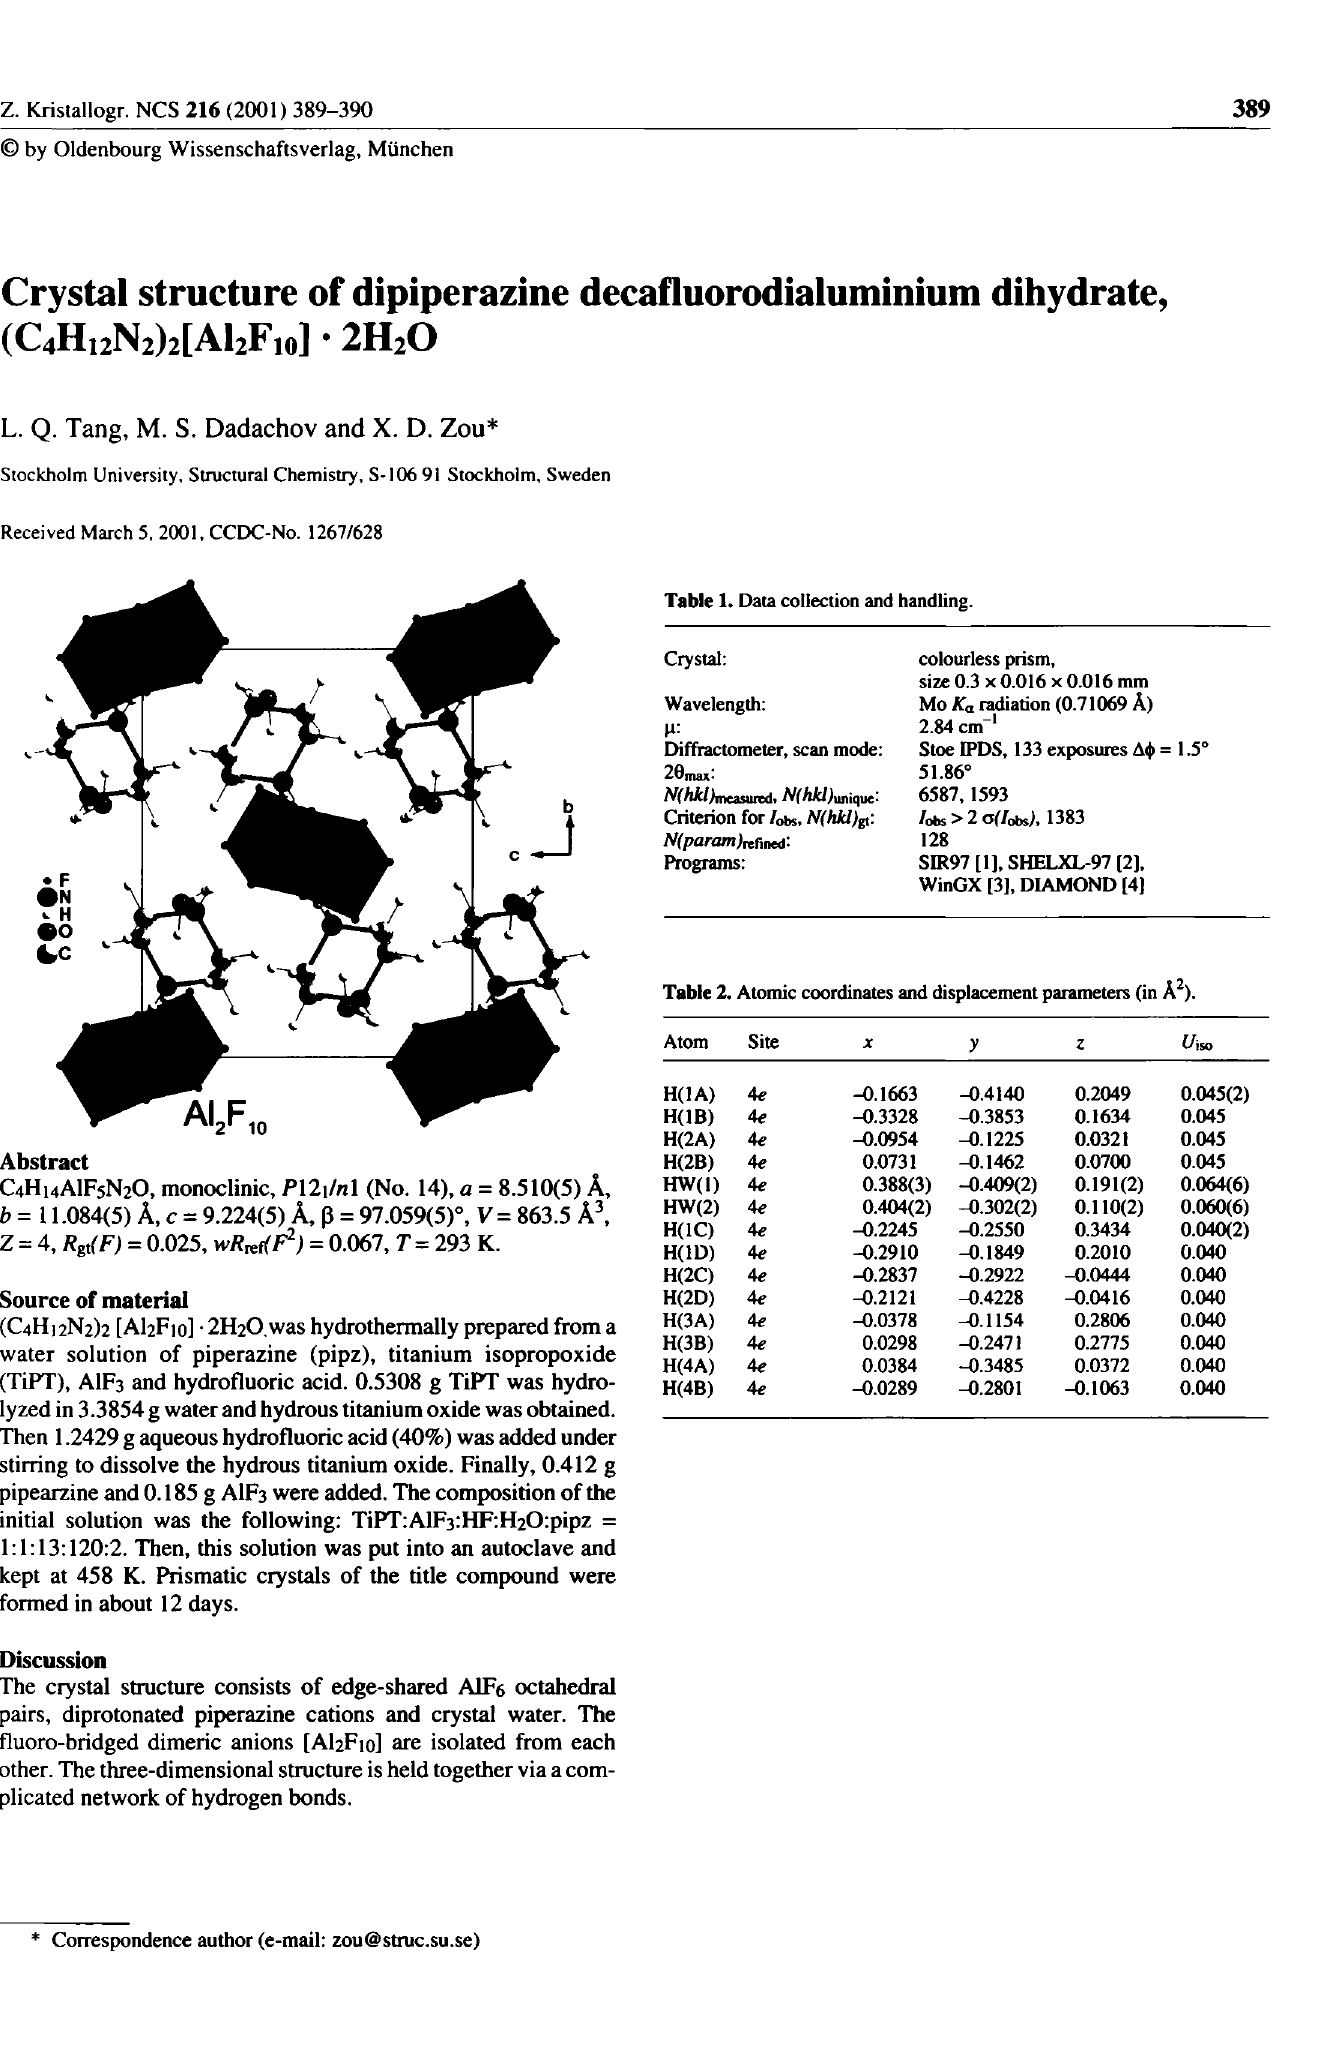
Table 2. Atomic coordinates and displacement parameters (in A 2